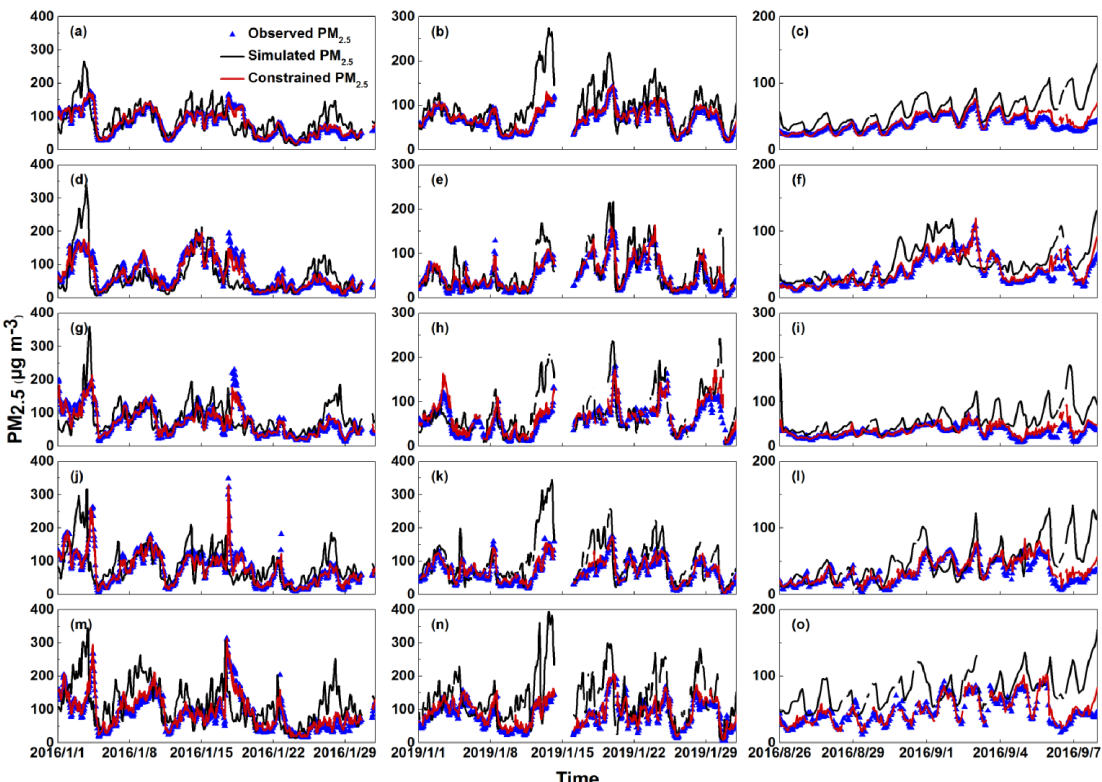
Figure 4. Time series of the comparisons between hourly observed, simulated, and constrained PM 2 . 5 concentrations for January 2016 (left column), January 2019 (middle column), and the G20 summit (right column) over (a–c) the whole domain as well as in four representative cities, which are as follows: (d–f) Shanghai, (g–i) Hangzhou, (j–l) Nanjing, and (m–o) Hefei. The black circles, black lines, and red lines denote the hourly observed, simulated, and constrained PM 2 . 5 concentrations,